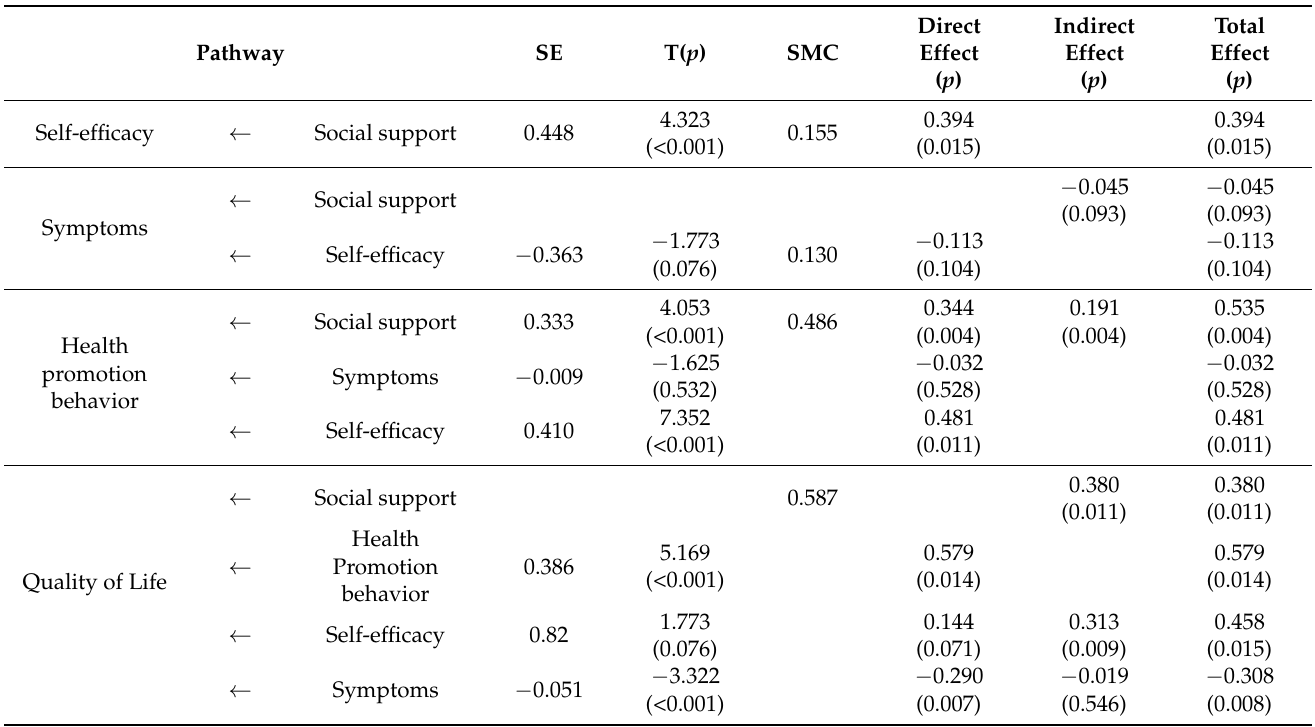
Table 3. Modified model of Standardized Regression